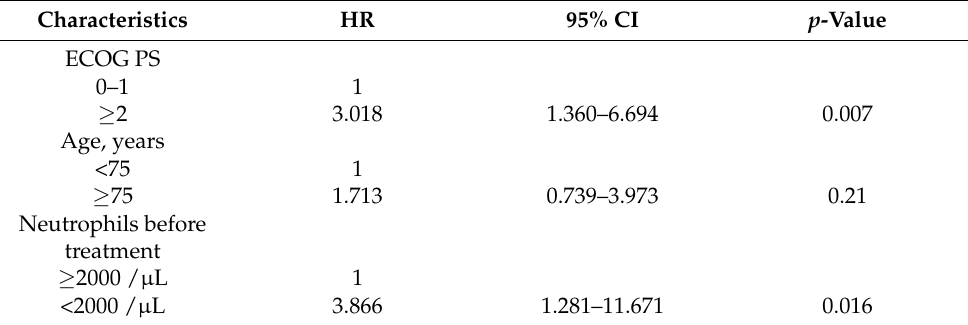
Table 6. Potential risk factors for FN by the multivariate Cox proportional hazards analysis ( N =